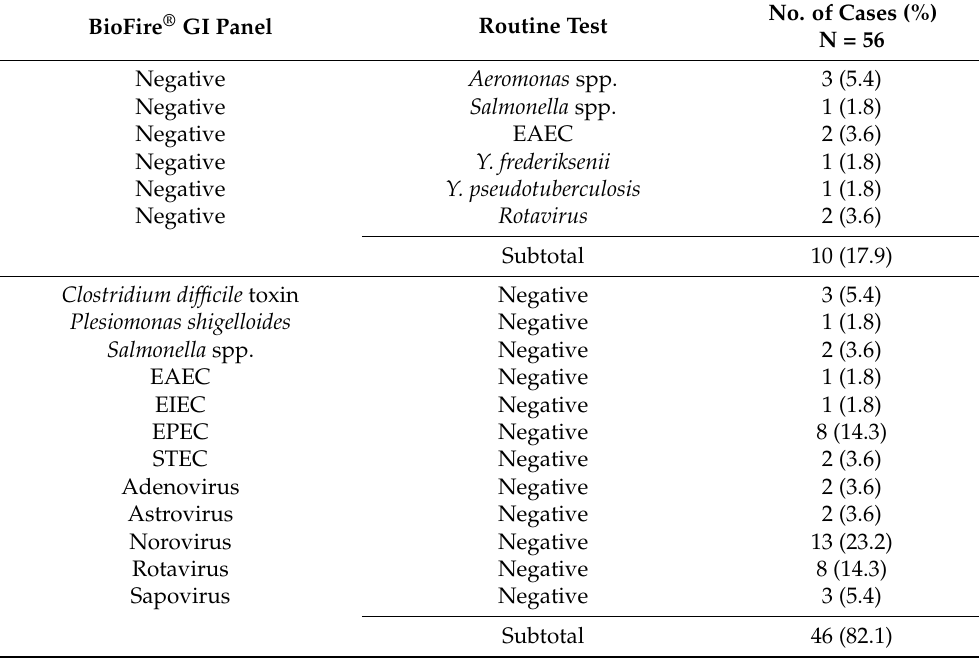
Table 4. Discrepancies of identified stool pathogens in BioFire ® GI Panel and conventional tests in the prospective cohort with community-onset